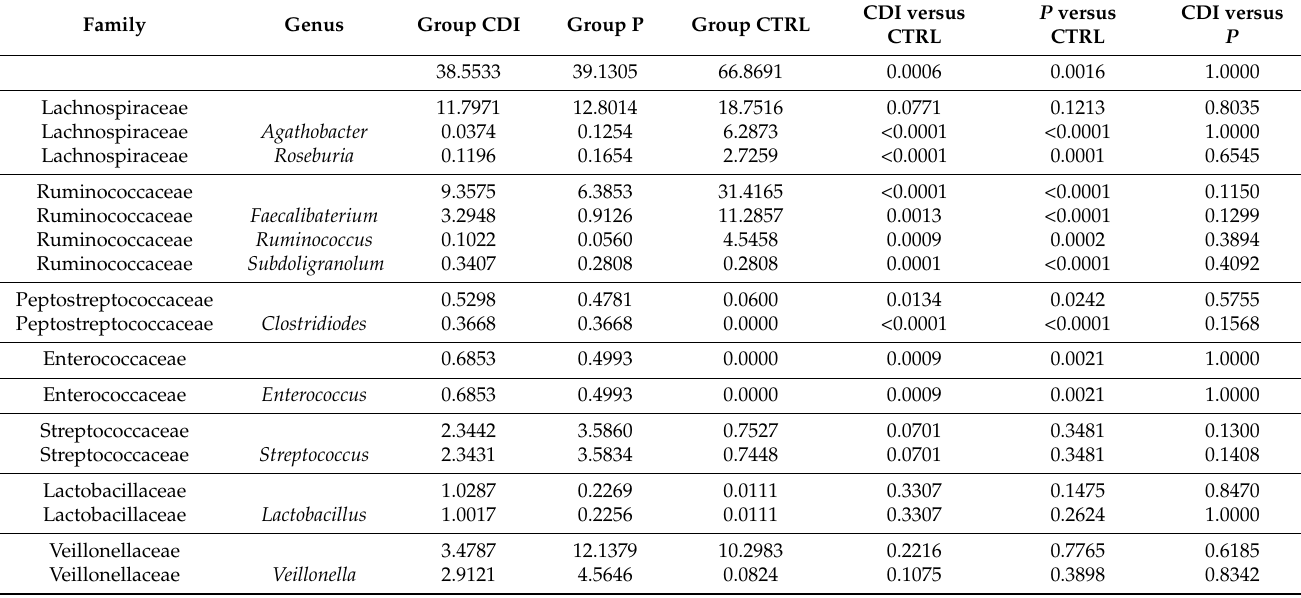
Table 3. Composition analyses of key OTUs of phylum Firmicutes in study